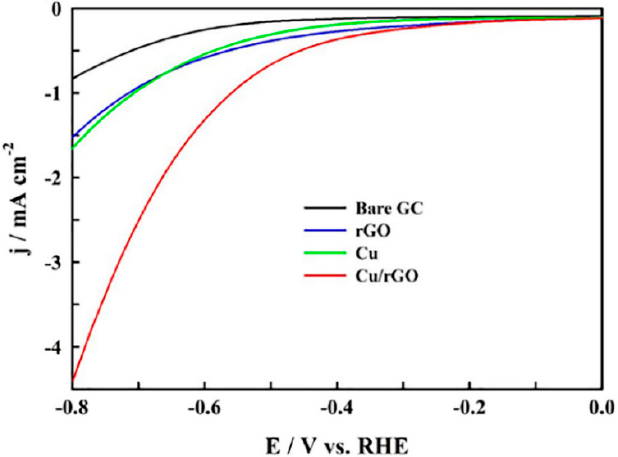
Figure 3. Linear sweep voltammogram (LSV) for glassy carbon (GC), rGO, Cu nanoparticles (NPs), and Cu/rGO in a 0.1 M NaHCO 3 solution at a scan rate of 20 mVs − 1 . Reproduced with permission [33]. RHE: reversible hydrogen electrode.